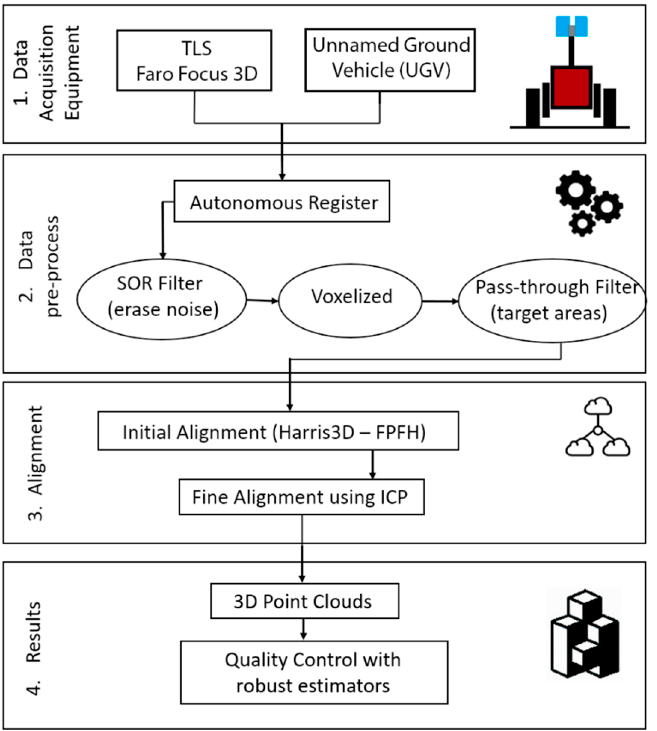
Figure 2. Methodology proposed for automatic registration of point clouds.